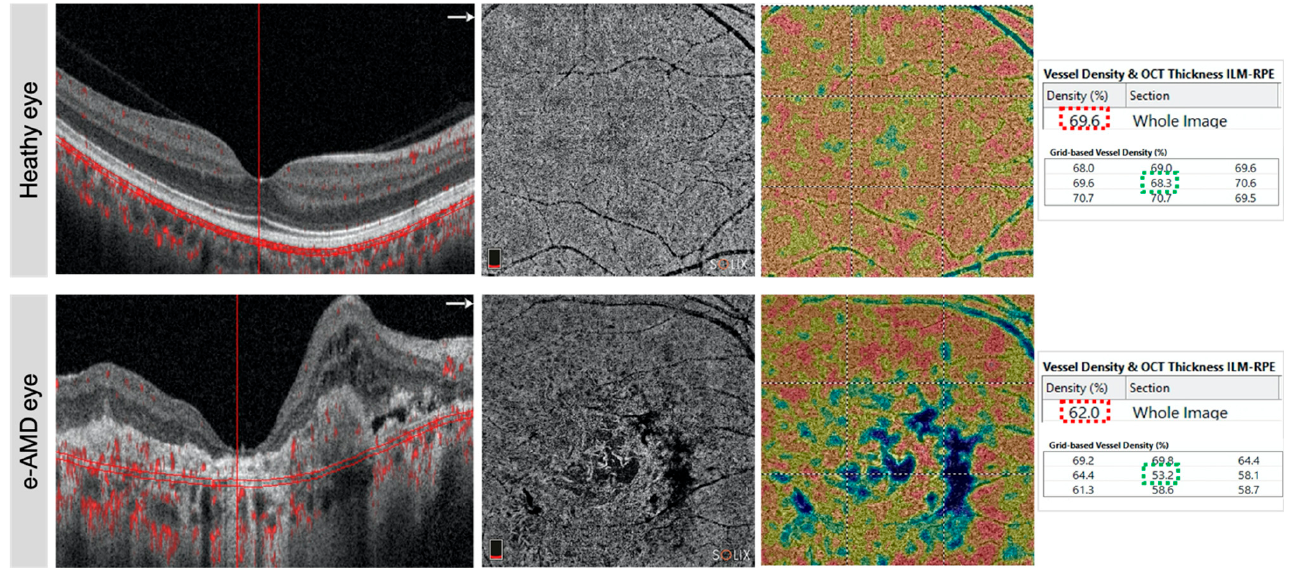
Figure 4. Healthy and advanced exudative AMD eyes details of B-scan ( left ), OCT angiography ( middle ) in correspondence of choriocapillaris, and relative vessel density analysis ( right ). The B-scan shows the flow analysis slab (red line) in choriocapillaris. The automated vessel density in the whole and fovea area were collected for statistical evaluation.